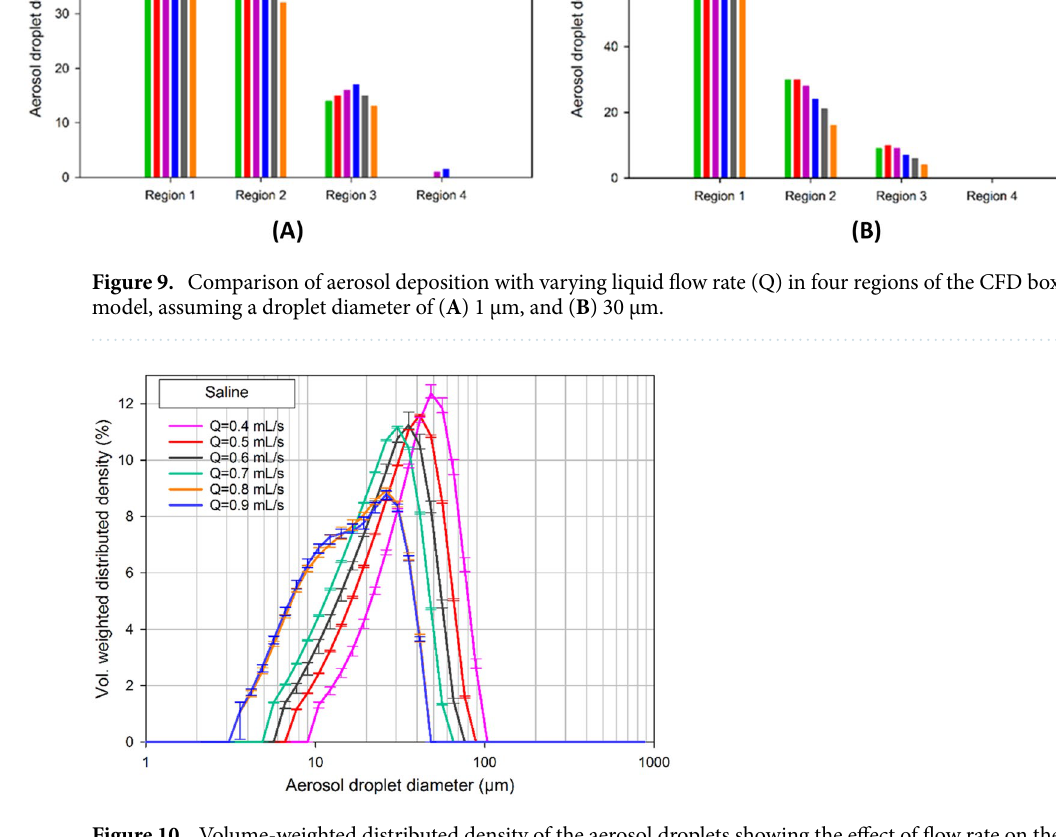
Figure 10. Volume-weighted distributed density of the aerosol droplets showing the effect of flow rate on the droplet size. A range of flow rates between 0.4 and 0.9 mL s −1 was used. The nebulization was performed in an open space at an upstream maximum pressure of 20